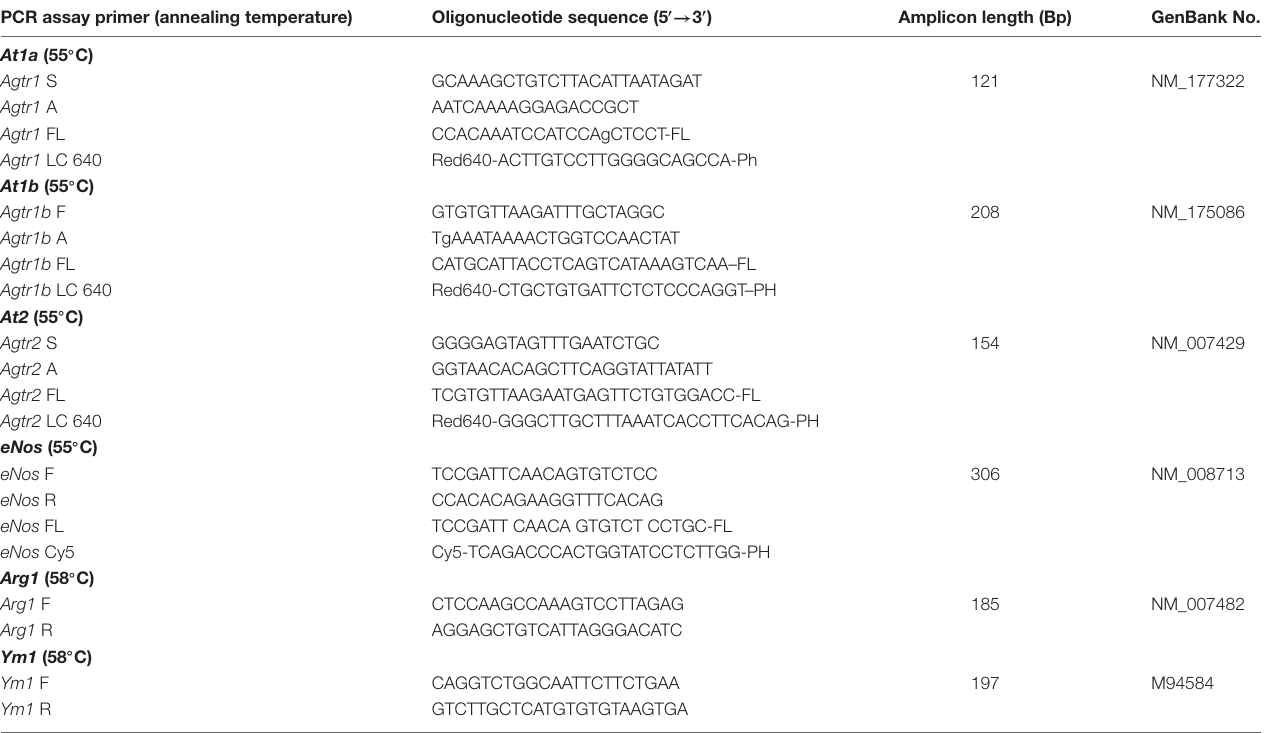
TABLE 2B | Primers and probes for quantitative real-time PCR. PCR assay primer (annealing temperature) Oligonucleotide sequence (5 (cid:48) → 3 (cid:48)